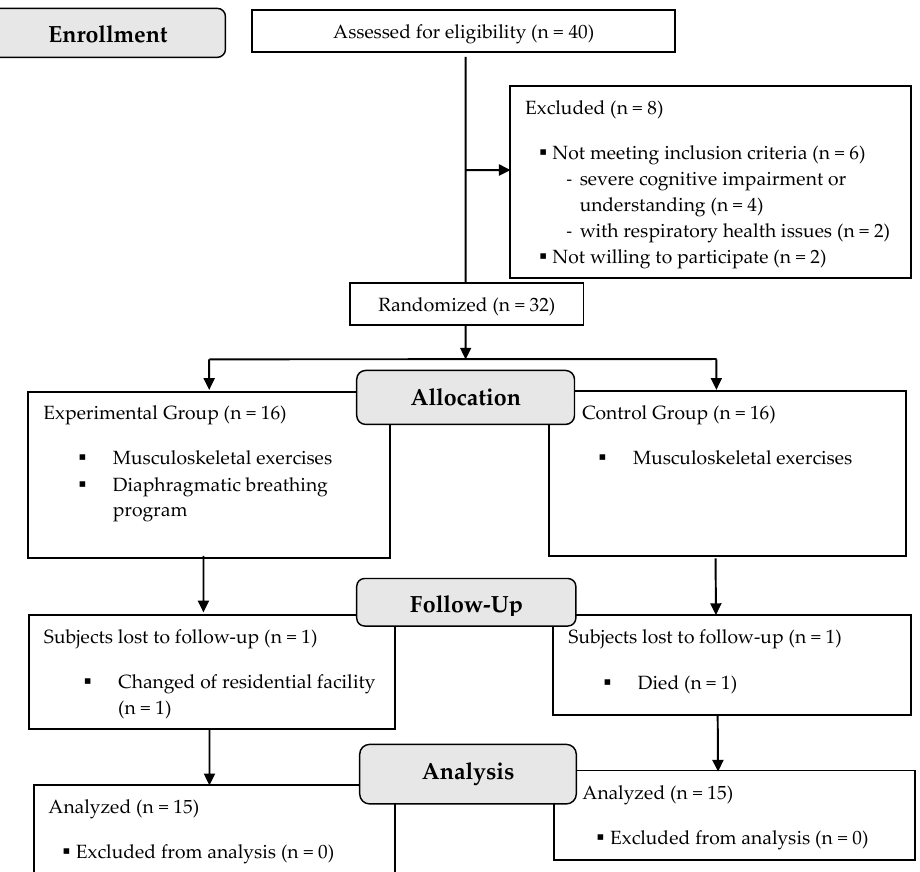
Figure 2. Flowchart according to the CONSORT statement for the report of randomized trials.